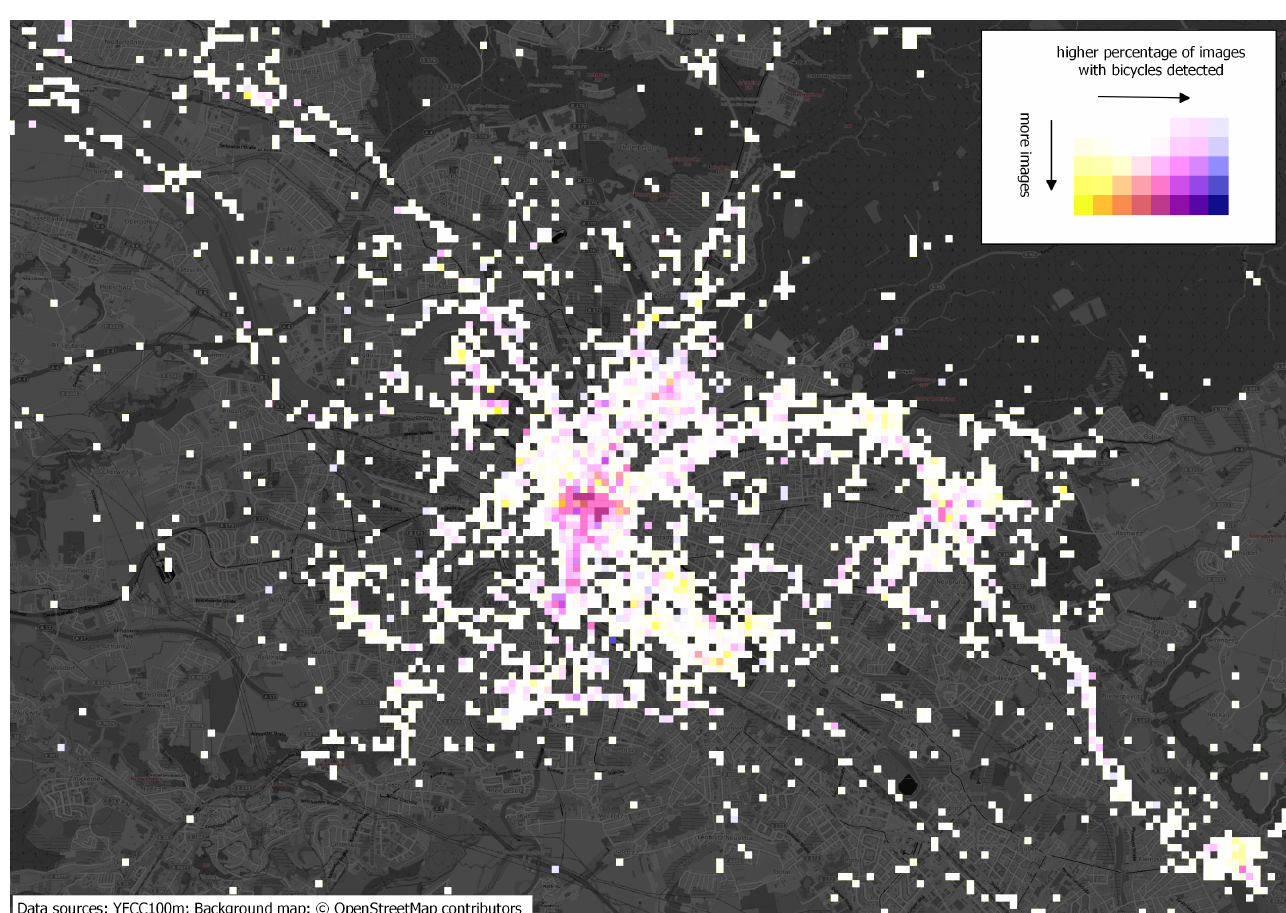
Figure 11. The map shows a combination of the total number of images with the percentage of images containing a bicycle for each grid cell with a size of 100 × 100